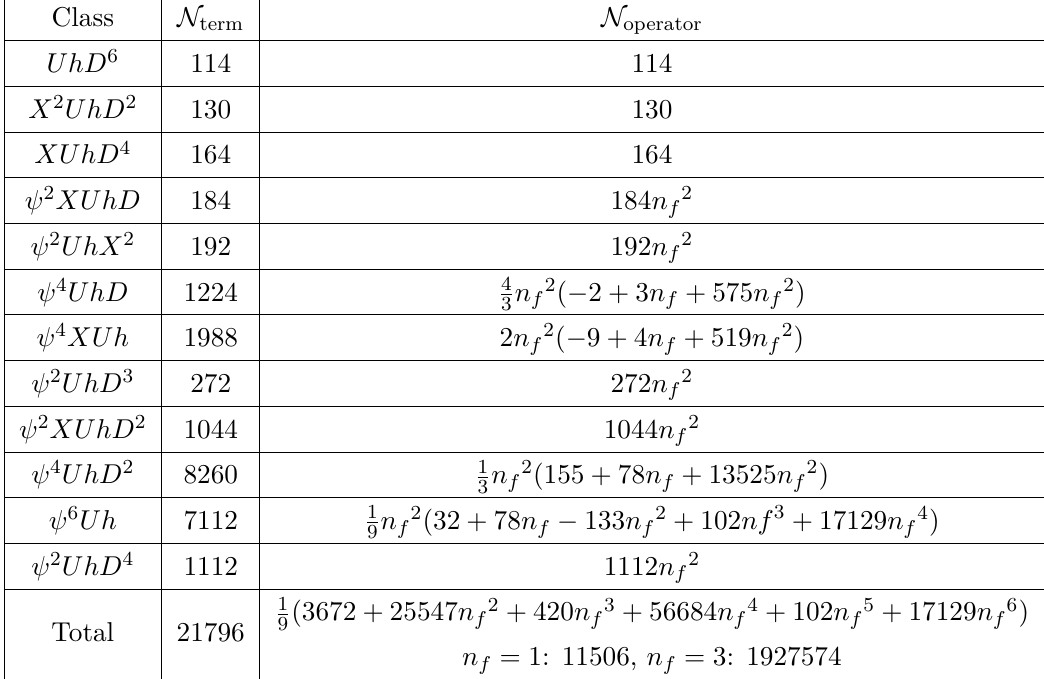
= 1 : 11506, n = 3 : 1927574 n f f